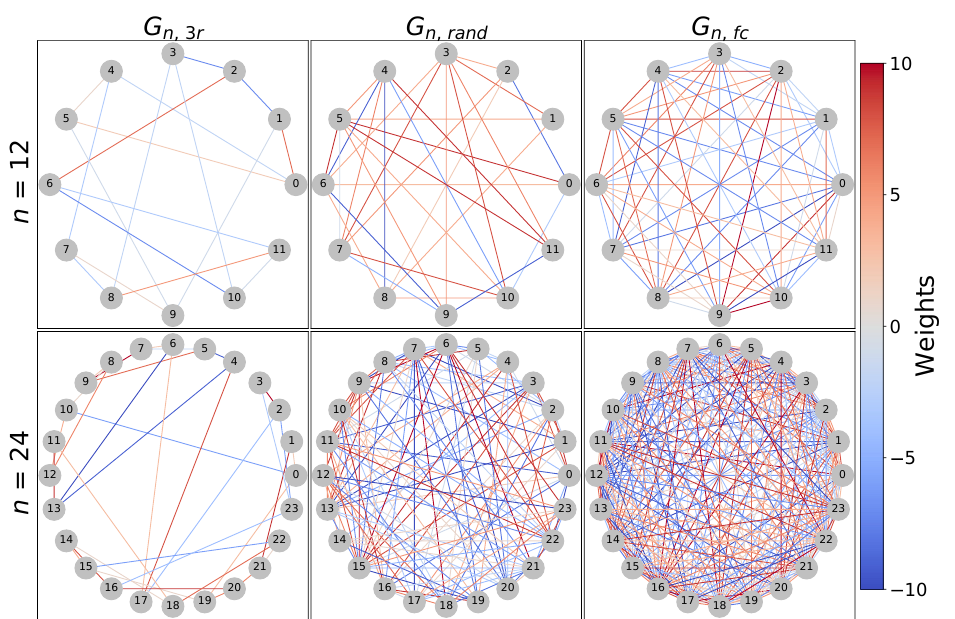
Figure 3. The graphs used for the evaluation of different hyperparameter settings: G n , 3r , G n , rand , and G n , fc with n ∈ { 12,24 }